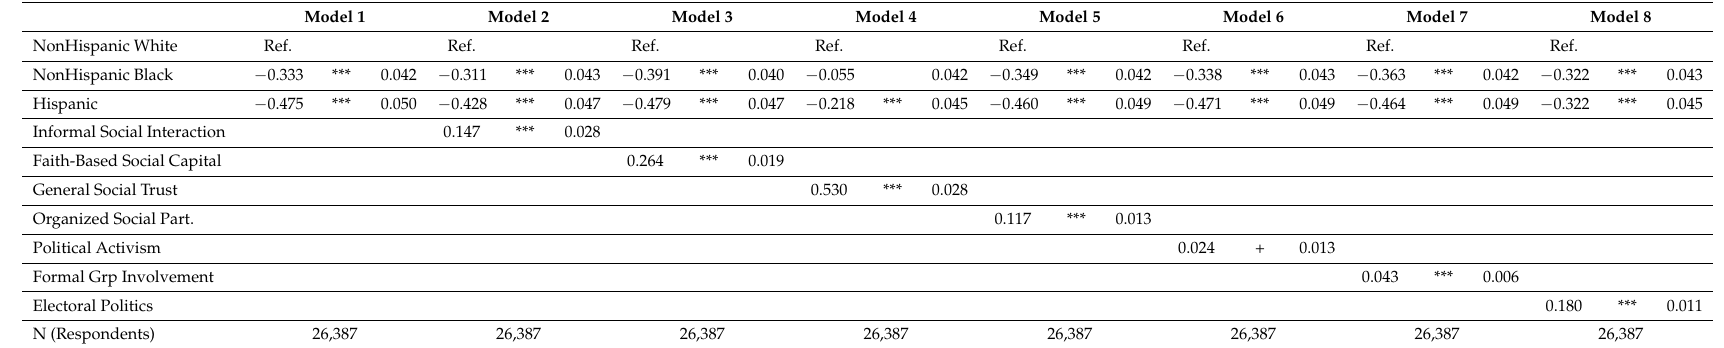
Table 3. Results from multilevel ordered logistic regression models predicting self-rated health.